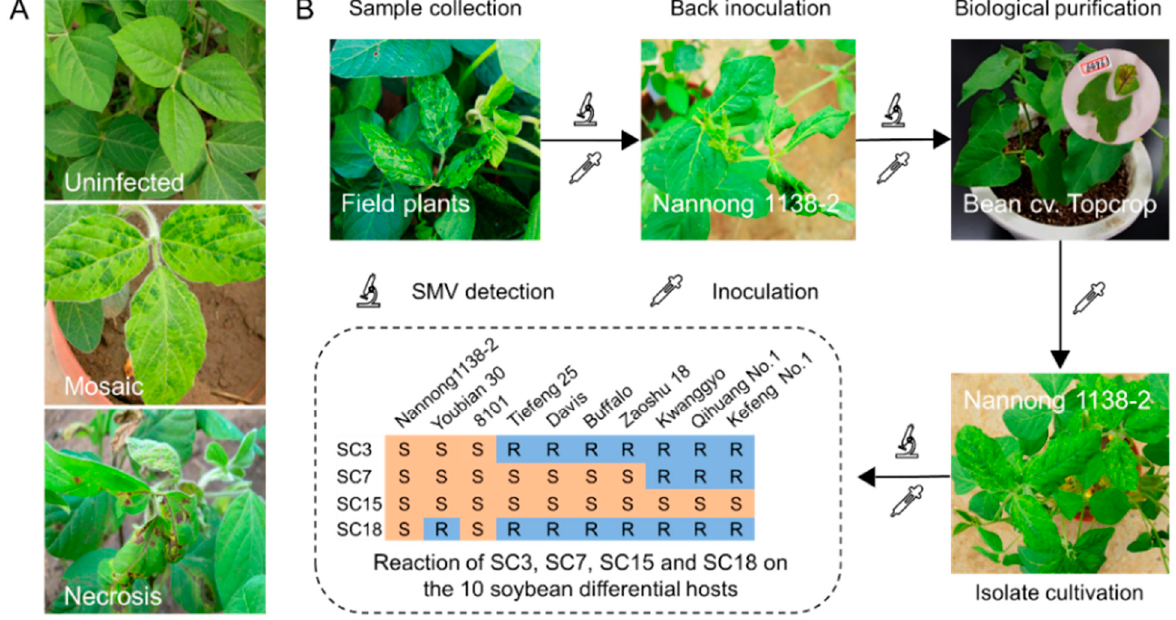
Figure 2. Biological purification and identification of the four SMV strains. ( A ) The typical mosaic and necrosis symptoms caused by SMV infection on soybean plants; ( B ) workflow diagram of the biological purification and identification of the four SMV strains.